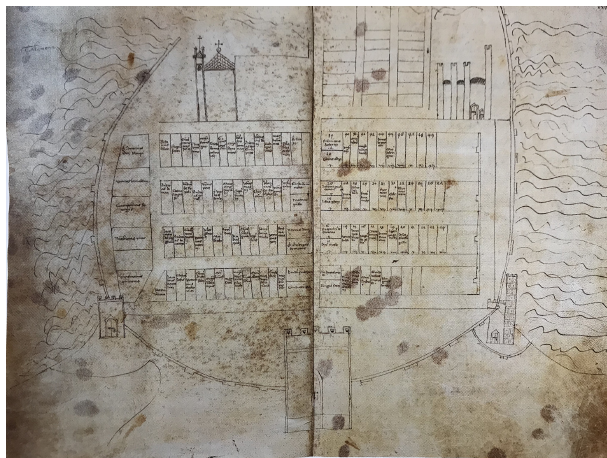
Figure 12. New city layout of Talamone with plots for new settlers from the mother city. Source: Archivio di Stato di Siena, Caleffo Nero, cap 3, 21 December